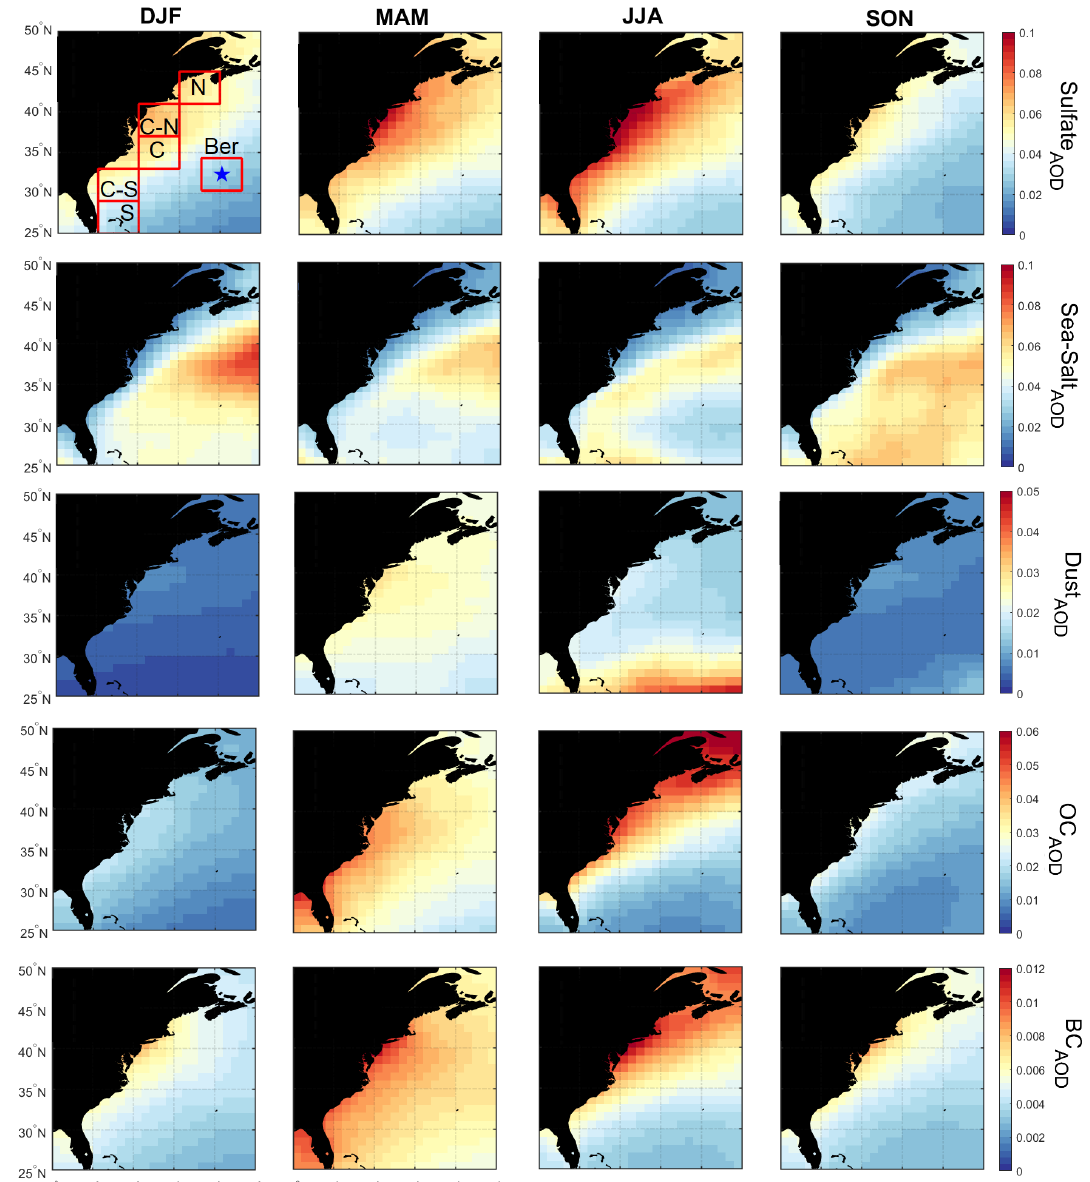
Figure 3. Seasonal maps of MERRA-2 speciated AOD based on data between January 2013 and December 2017. The boxes in the top left panel represent sub-domains examined in more detail throughout the study, with the blue star denoting